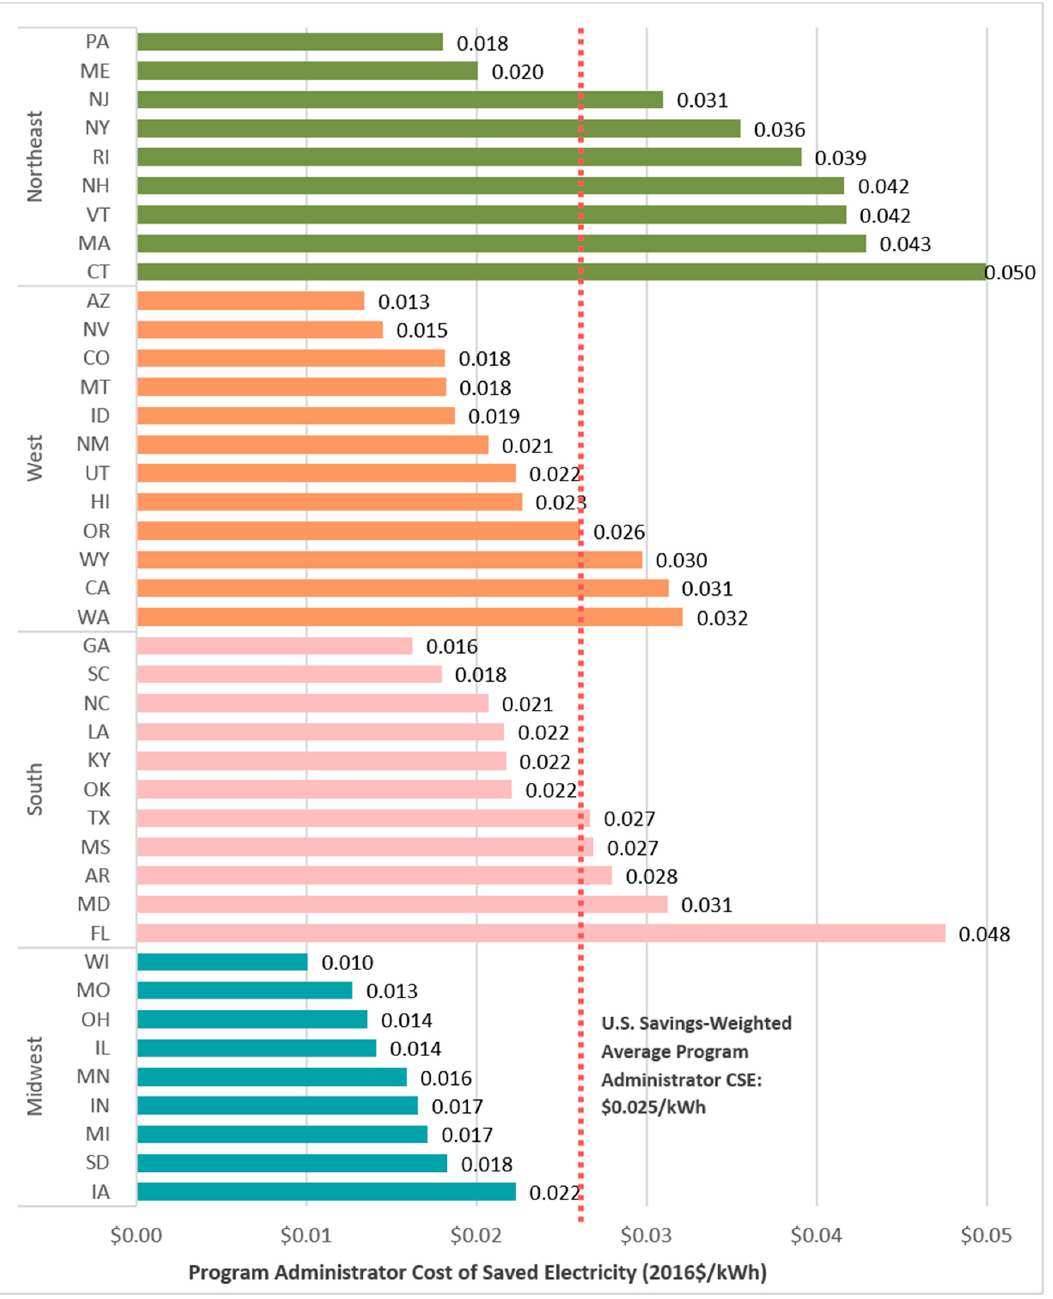
regional average. The state’s investor-owned utilities had elevated costs during our study period, 356